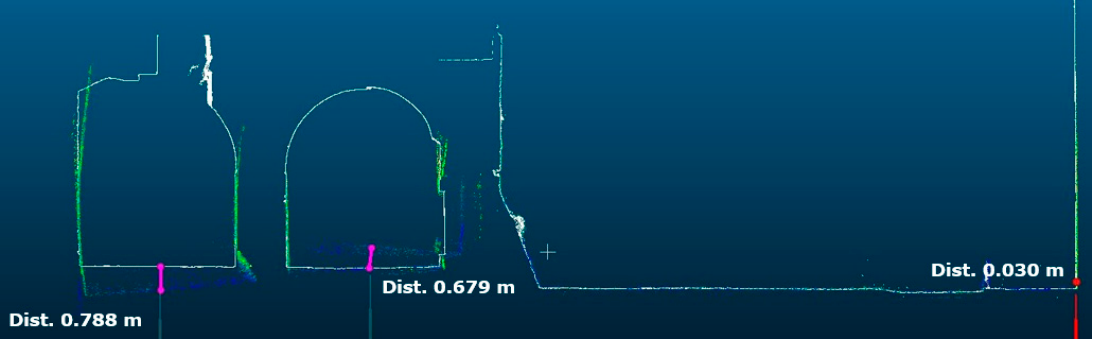
Figure 9. Kaarta Stencil, path 1. Cross Section 1 (reference data in white, compared dataset in colour).